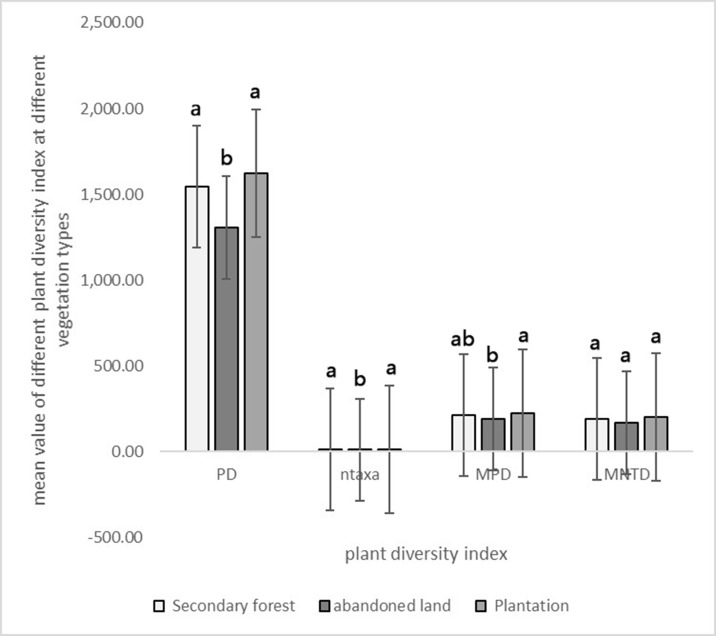
Phylogenetic diversity indices for different vegetation types.Error bars were constructed with one standard deviation of the means. PD refers to phylogenetic diversity. Ntaxa refers to the number of species. MPD refers to mean phylogenetic distance. MNTD refers to mean nearest taxon distance. Different letters represented significant differences at p = 0.05 among three different vegetation types.